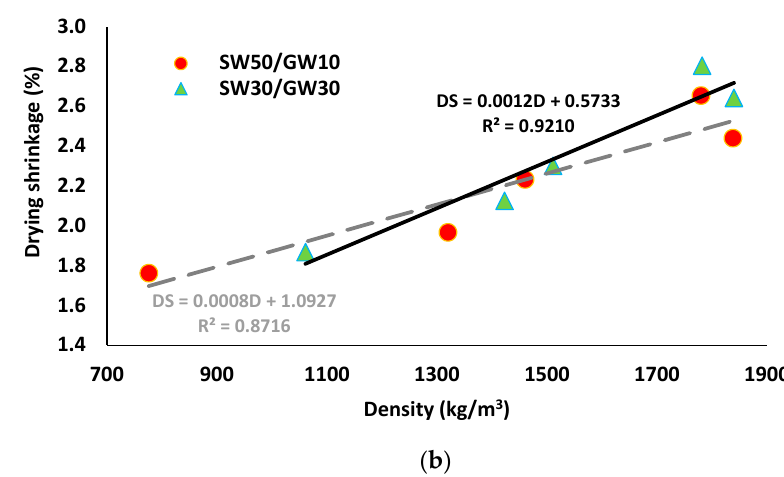
Figure 9. ( a ) The impact of adding PP fibers and different foam contents on the drying shrinkage (mm/mm) of mix compositions; ( b ) the relationship between the drying shrinkage and density of mix compositions.